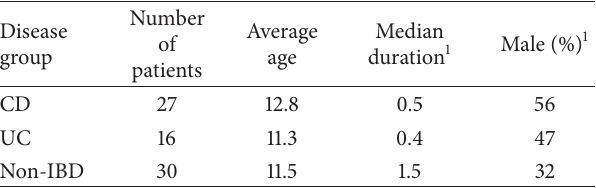
Table 2: Demographic